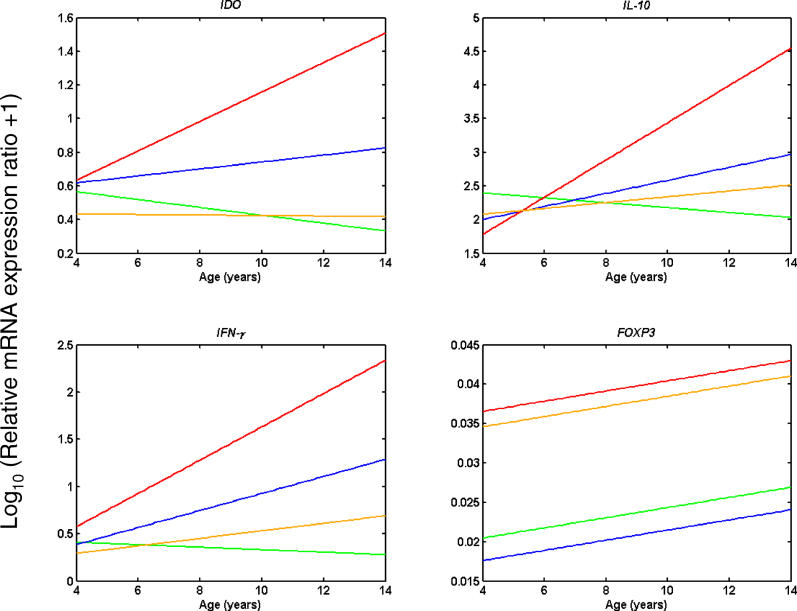
Age Modulation on Right Eye Conjunctival mRNA Expression: Analysis of CovarianceIndividuals were categorised using a combination of the presence of clinical signs of active trachoma (TF/TI) and the detection of chlamydial 16S rRNA. Regression models were fitted for the expression of each human mRNA assayed and age (years) within each category. The regression lines for individuals in each category are shown for each of the mRNAs, IDO (top left), IFN-γ (bottom left), IL-10 (top right), and FOXP3 (bottom right). Green line: clinically normal, uninfected individuals; blue line: clinically normal, infected individuals; red line: clinically diseased, infected individuals; and orange line: clinically diseased, uninfected individuals.